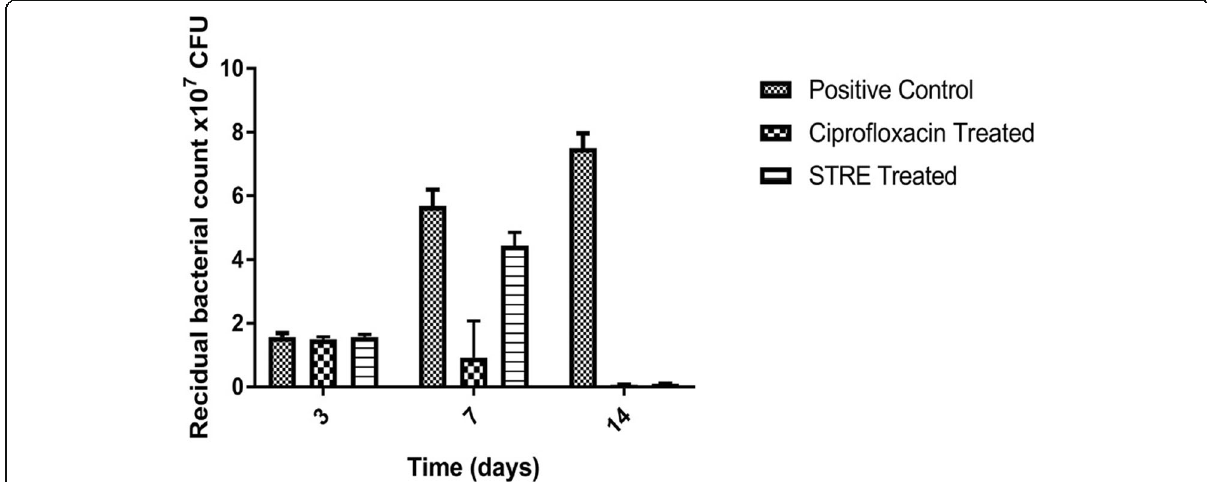
Fig. 2 Efficacy of treatment upon bacterial